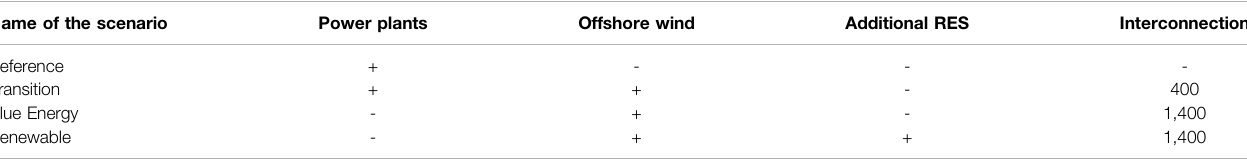
TABLE 3 | Parameters investigated in considered